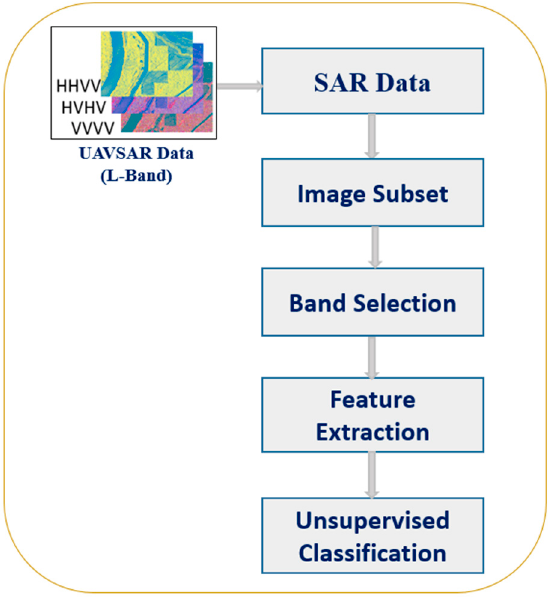
Figure 2. Processing steps for slide detection on levee.